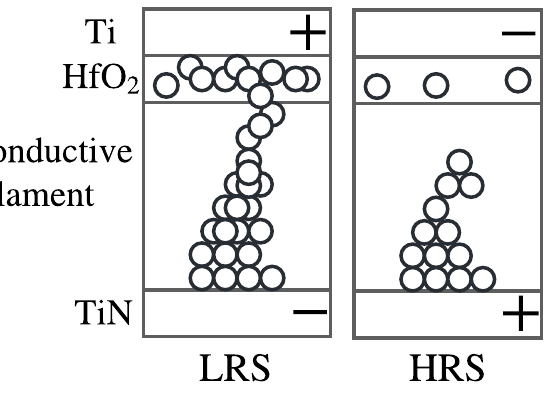
Figure 4. Operation of an RRAM